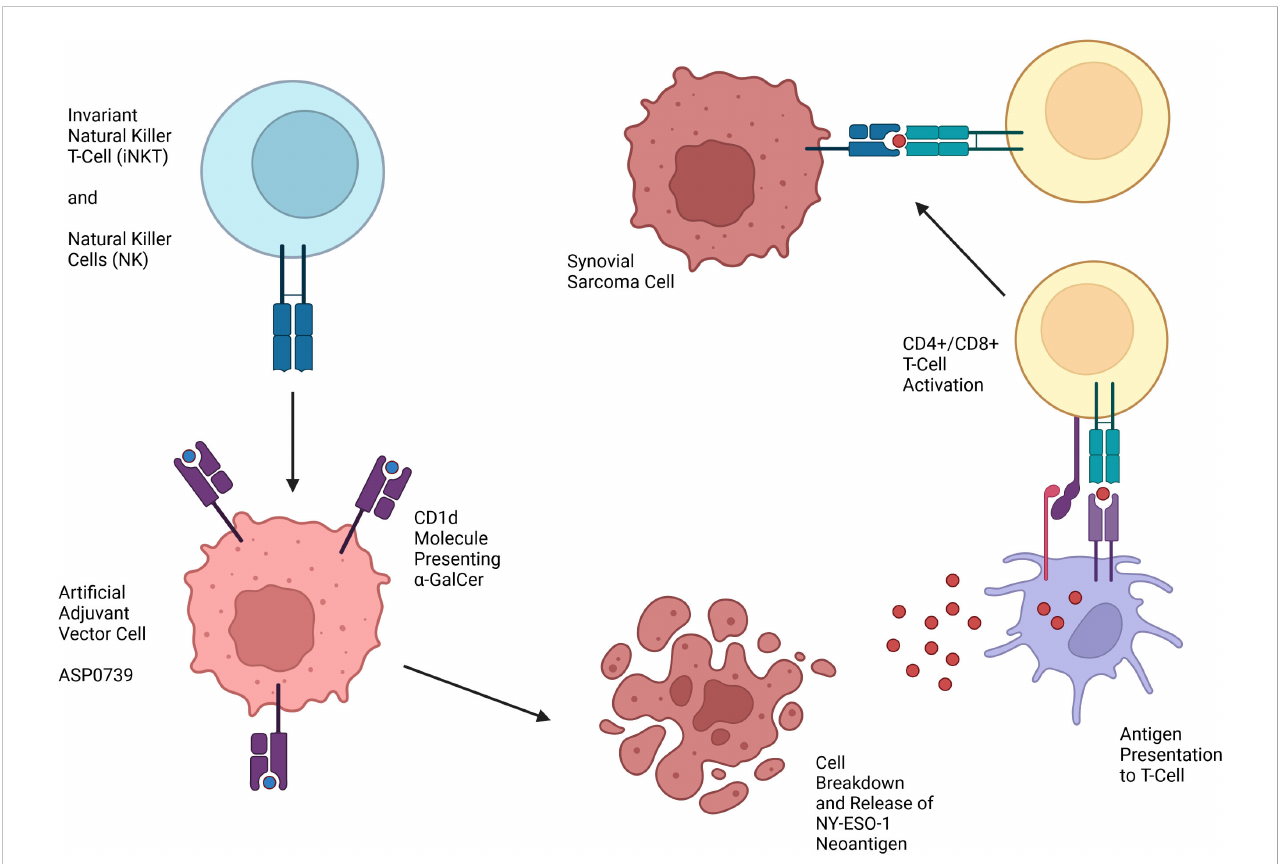
FIGURE 2 Mechanism of action of Arti fi cial Adjuvant Vector Cells targeting NY-ESO-1 for treatment of